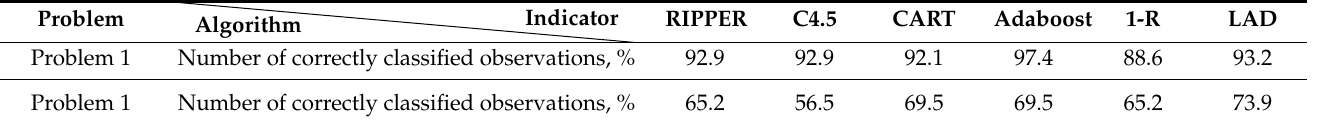
Table 7. Comparison of logical classification algorithms on practical